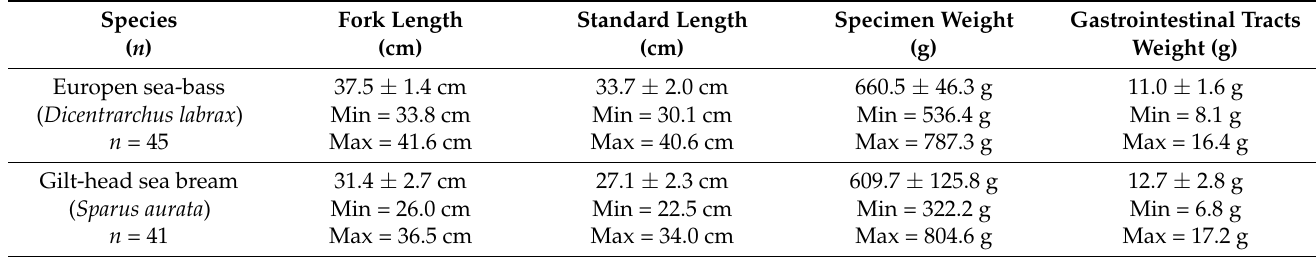
Table 1. Fork length, standard length, specimen weight and gastrointestinal tract weight of